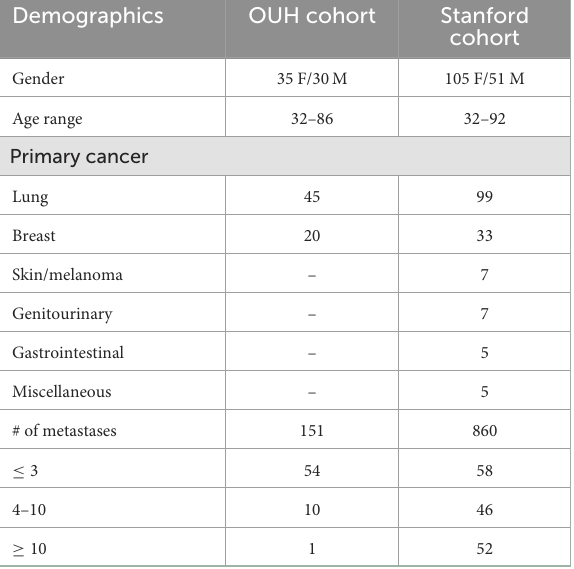
TABLE 2 Patient demographics for both hospital cohorts and the number of patients with a given number of